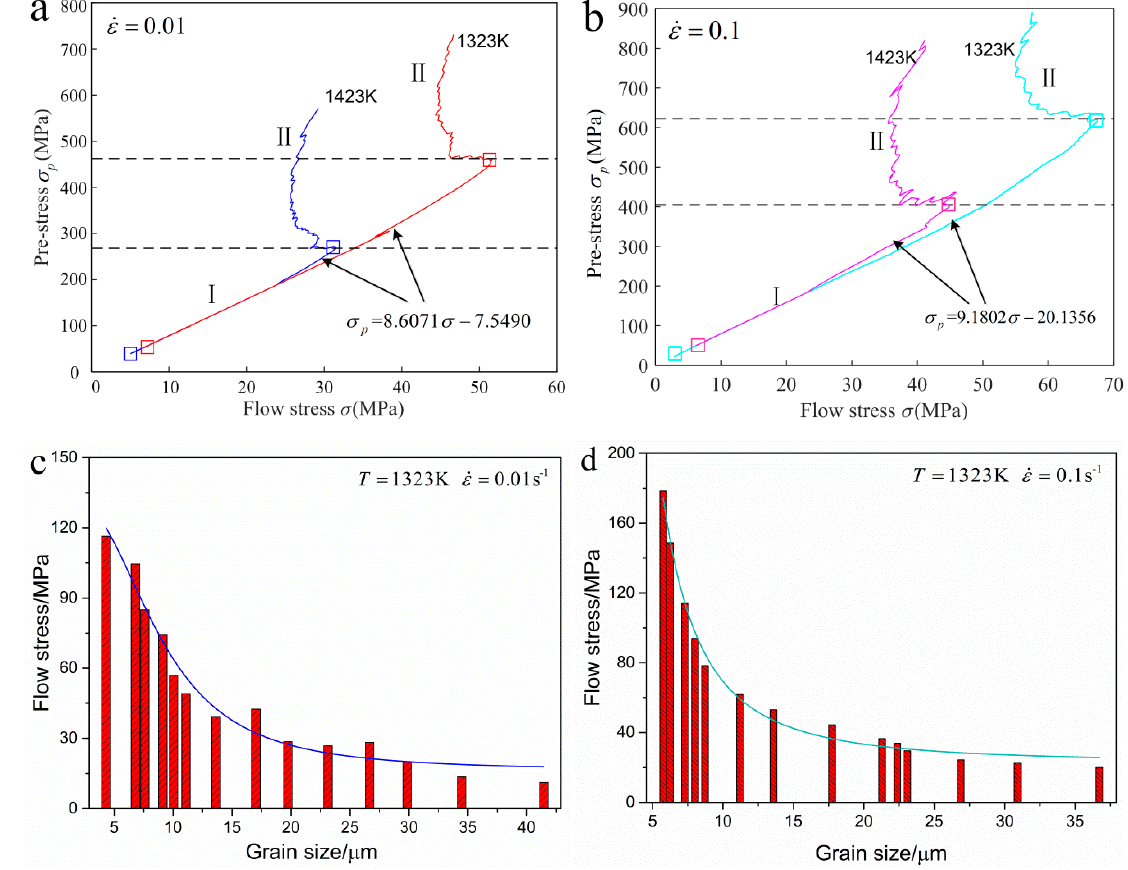
Figure 7. The functional relationship curves ( a ) σ − σ p , strain rate = 0.01 s − 1 ; ( b ) σ − σ p , strain rate = 0.1 s − 1 ; ( c ) σ − d drx , strain rate = 0.01 s − 1 ; ( c ) σ − d drx , strain rate = 0.1 s − 1